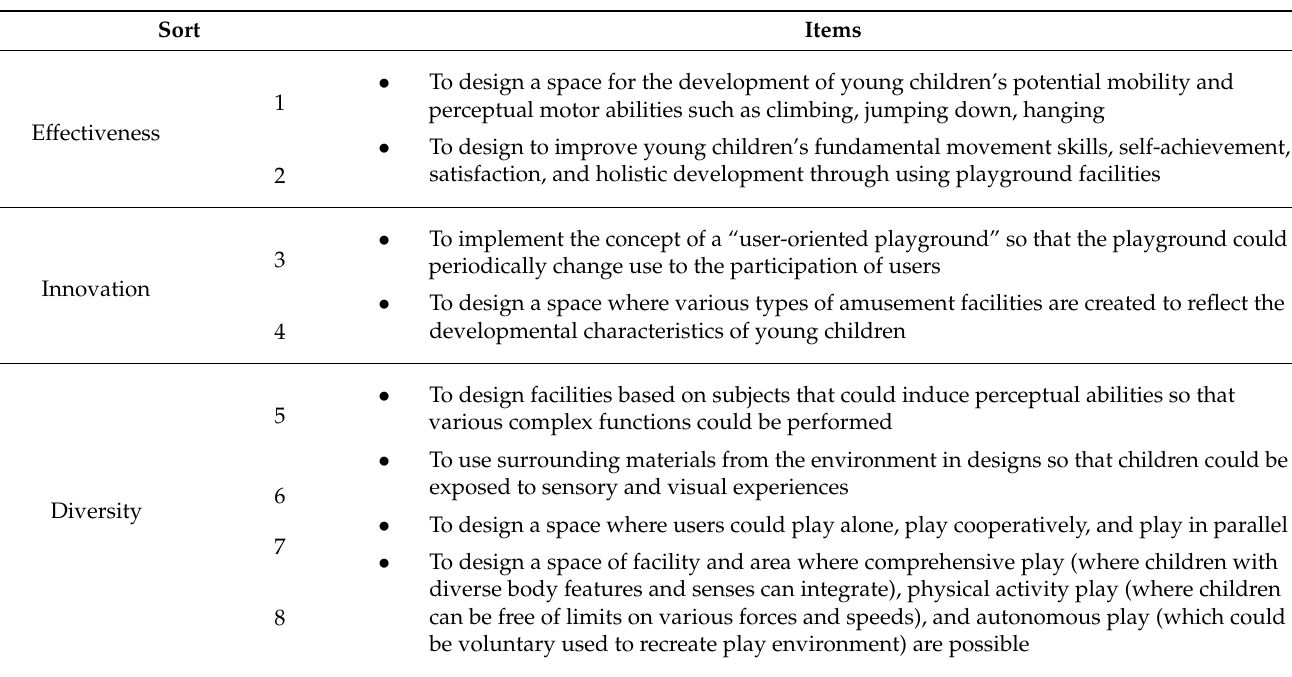
Table A2. Items Confirmed from Delphi Round